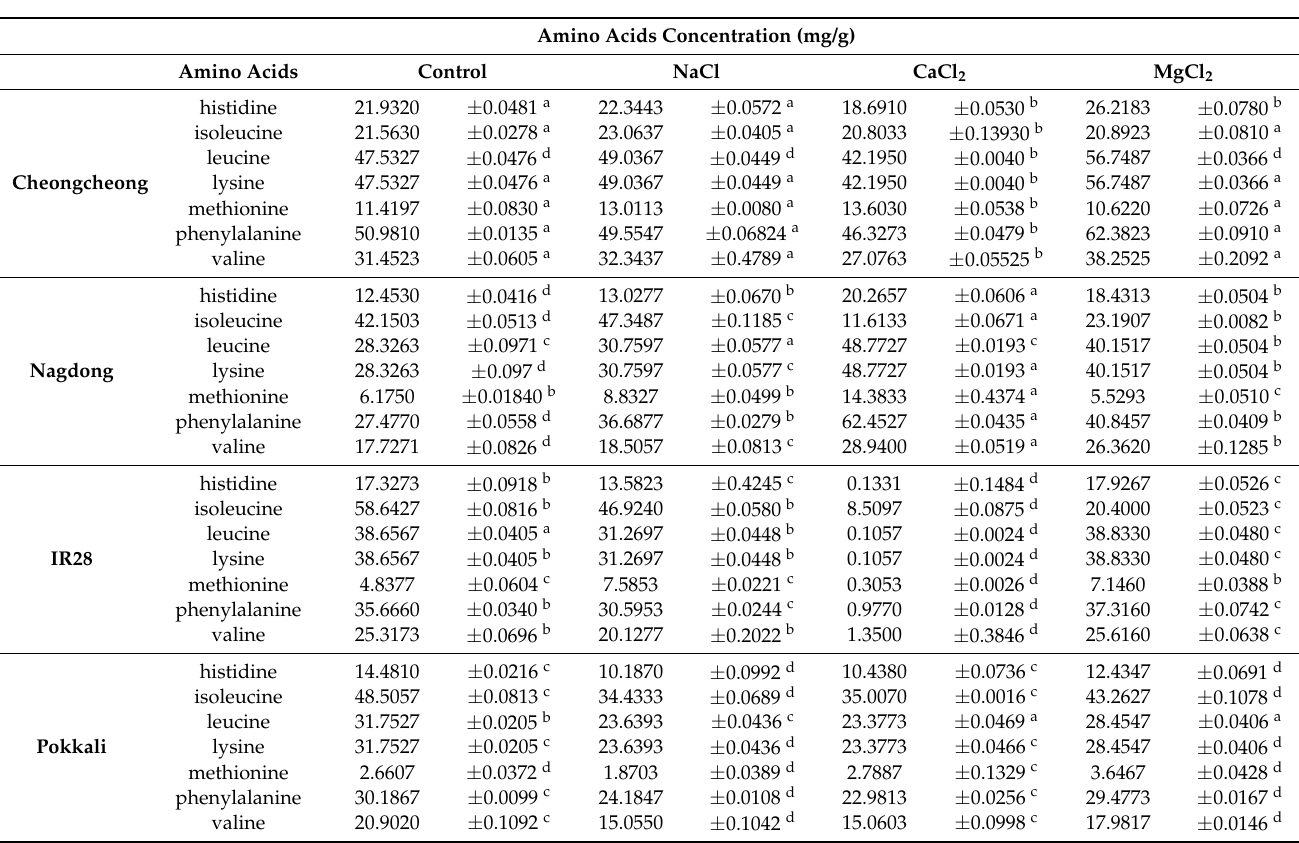
Table 1. Rice seedlings displayed differential regulation of essential amino acids following 24 h different salts stress. Different letters indicate significant differences between rice genotypes. Means ± SDs, n = 3; values with the same letter were not found to be significantly different from each other as per Duncan’s multiple range test at p <